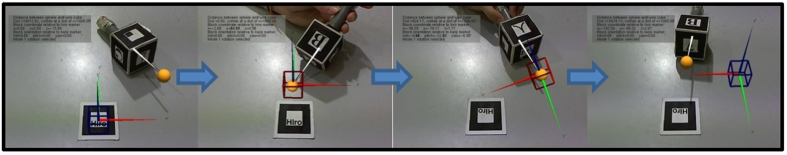
Pick and place sequence of the virtual object.The blue wireframe cube that was picked turns red when in contact with the teach pendant, and returns blue once placed at another position.